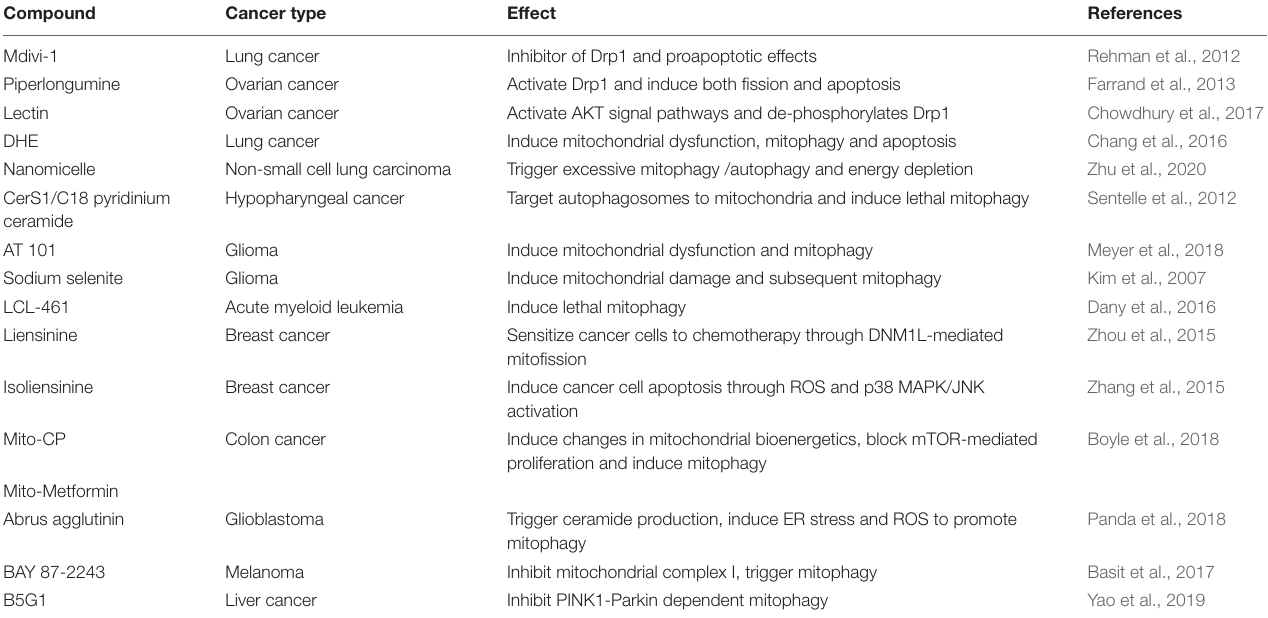
TABLE 1 | Compounds targeting mitochondria in the treatment of